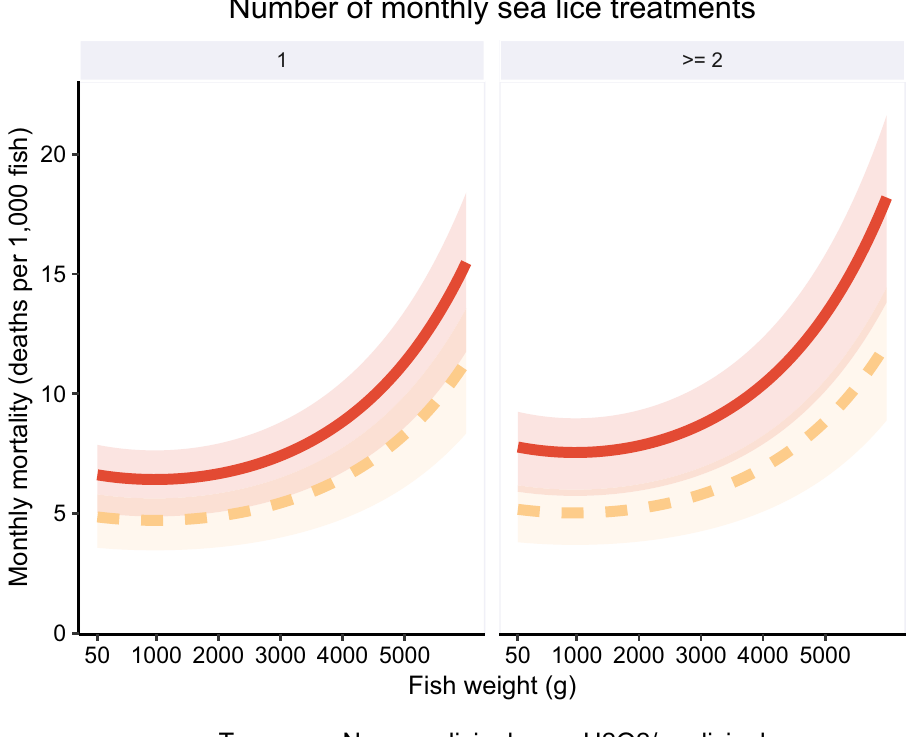
Figure 5. Atlantic salmon mortality predictions from the final model based on fish weight and number of sea lice treatments per month. The lines and shaded areas in the plots show the mean and interquartile range of predicted values, respectively. The different colors represent two types of sea lice treatments for comparisons. One is bath treatments using H 2 O 2 or medicinal compounds, such as azamethiphos and pyrethroids. The other is non-medicinal treatments with removal of sea lice by flushing or brushing, warm water or freshwater baths. This figure was generated using the Tidyverse 46 package in R 47